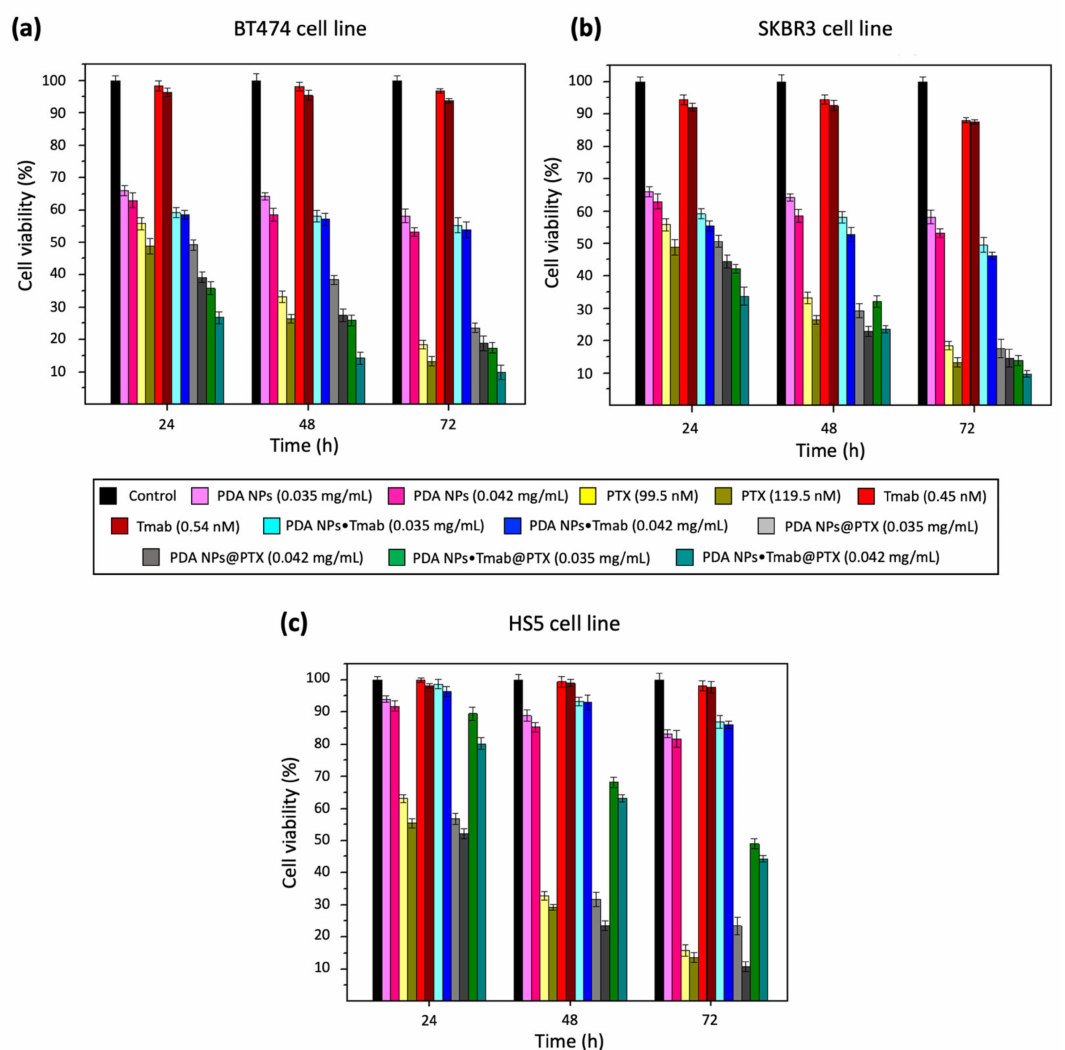
Figure 3. Survival rates of BT474 ( a ), SKBR3 ( b ) and HS5 ( c ) cells after treatment with 0.035 and 0.042 mg/mL bare PDA NPs, PDA NPs • Tmab, PDA NPs@PTX and PDA NPs • Tmab@PTX, as well as with concentrations of free Tmab and PTX similar to those loaded to PDA